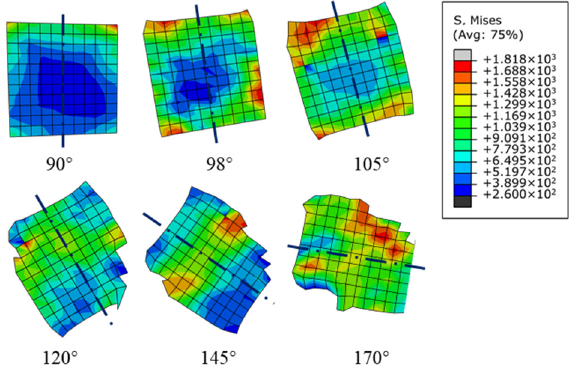
Figure 9. Particle rotation during cutting simulation of SiC p/Al reinforced with irregular polygonal